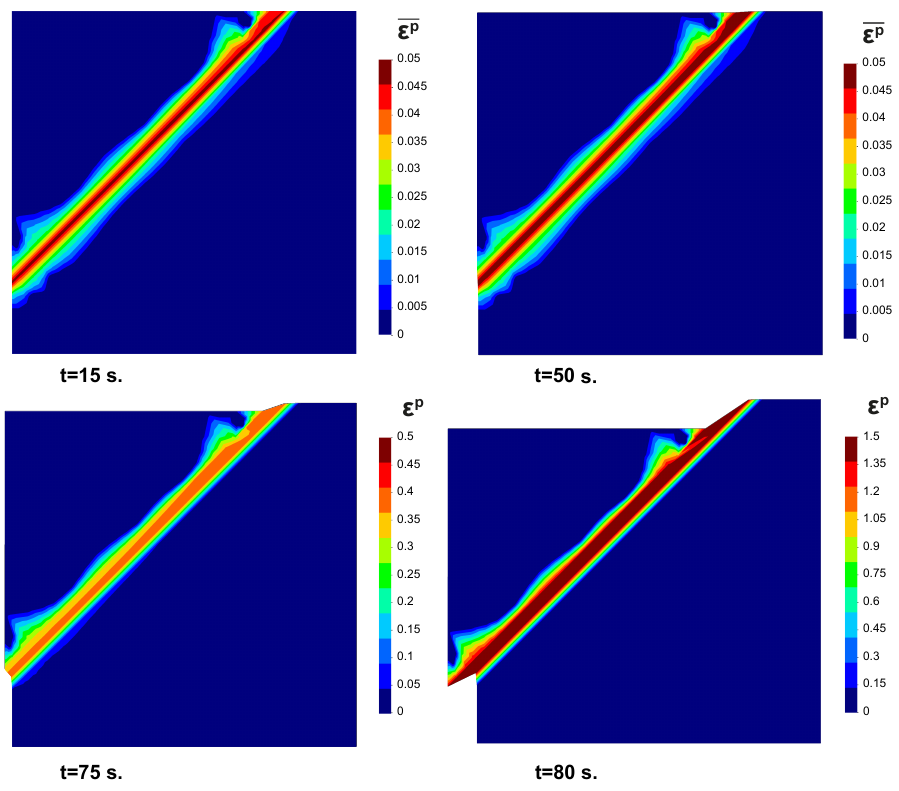
Figure 14. Distribution of the equivalent plastic strain in the deformed model obtained with the eigendegradation model at 4 different times.